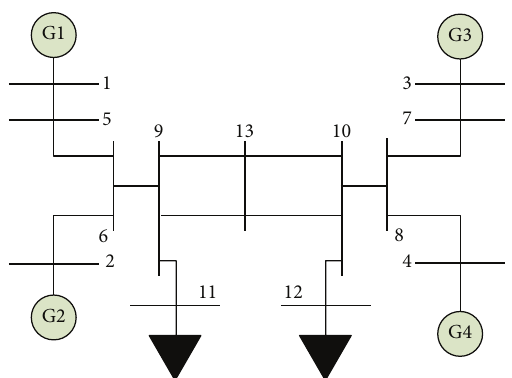
Figure 1: Single line diagram of two-area four-machine power sys- tem.